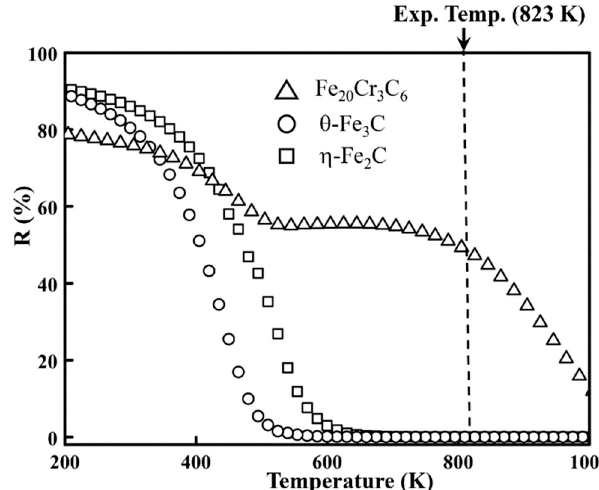
Figure 9. Magnetic-field-induced free energy change of η -Fe 2 C, θ -Fe 3 C and Fe 20 Cr 3 C 6 with a 12 T external field.